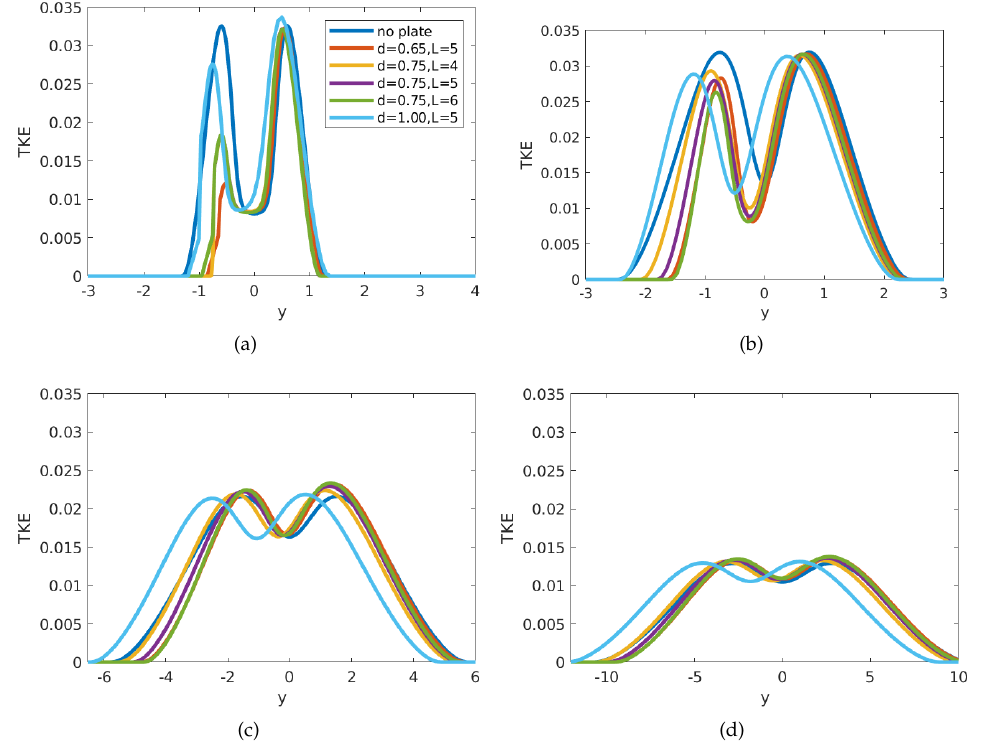
Figure 6. Turbulent kinetic energy profiles along vertical direction, for different configurations: ( a ) x = 4 D j ; ( b ) x = 10 D j ; ( c ) x = 25 D j ; ( d ) x = 45 D j